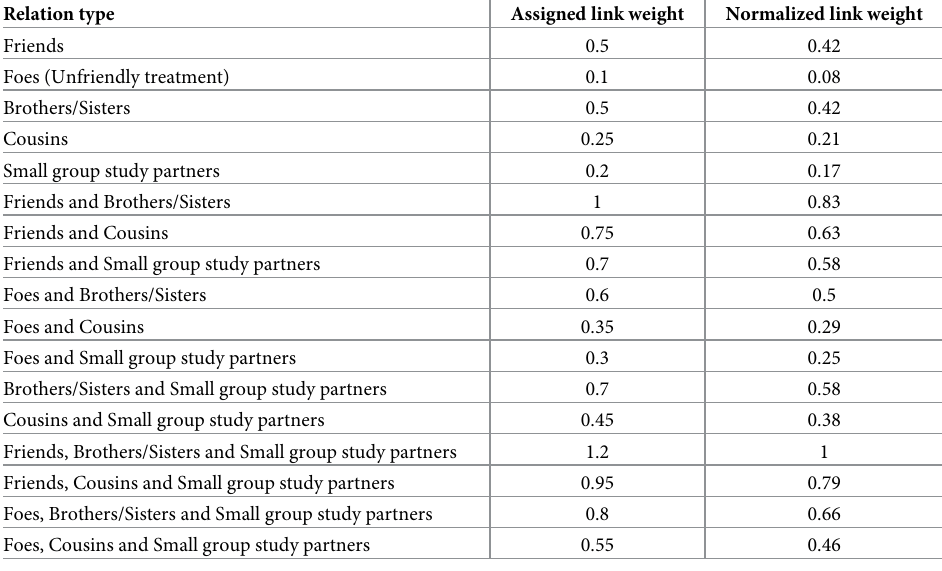
Table 1. Weighted links. The links weight is associated with the number and type of links between nodes. The last col- umn shows the normalization of the assigned link weight. Relation